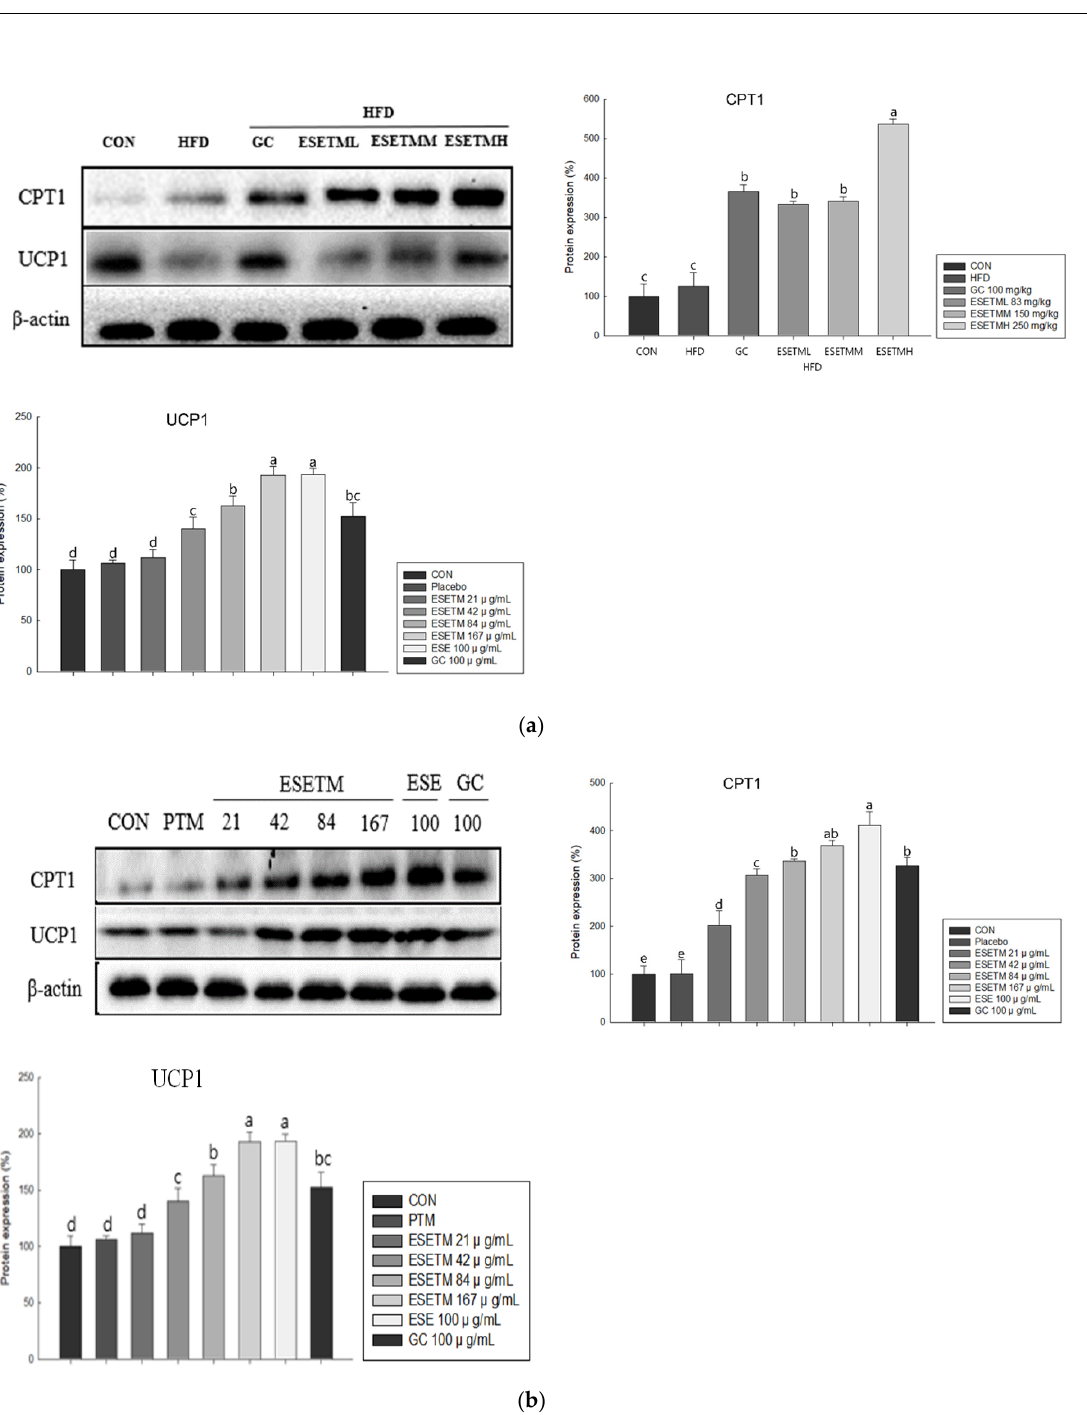
Figure 7. Effects of ESETM on thermogenesis and browning proteins expression in ICR mice fed HFD after 7 weeks and adipocytes treated with ESETM. ( a ) Western blots of thermogenesis and browning proteins in WAT. ( b ) Western blots of thermogenesis and browning proteins in adipocytes. Data are shown as the means ± standard deviation (SD) ( n = 5). Different low case letters above columns indicate statistical differences at p < 0.05.